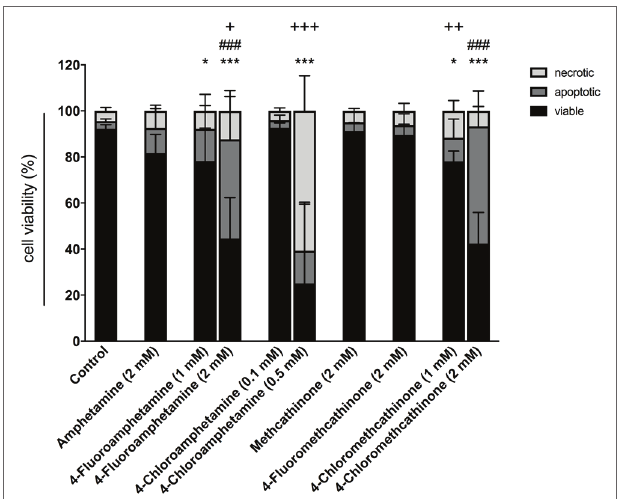
FIGURE 6 | Mechanisms of cell death in HepG2 cells after drug exposure for 24 h. Data are expressed as mean ± SEM, and numbers in parentheses indicate the number of individual experiments: amphetamine (7), 4-fluoroamphetamine (8), 4-chloroamphetamine (4), methcathinone (7), 4-fluoromethcathinone (7), and 4-chloromethcathinone (7). Significance levels are given as * p < 0.05, *** p < 0.001 (viable cells); ### p < 0.001 (apoptotic cells); + p < 0.05, ++ p < 0.01, +++ p < 0.001 (necrotic